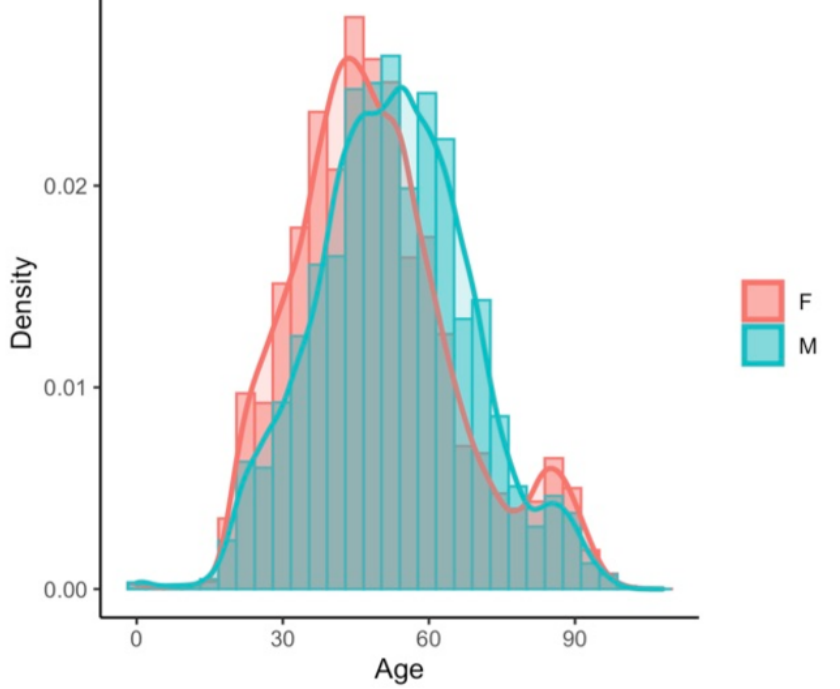
Figure 3. Age profile of patient users of the teleconsultation service, according to